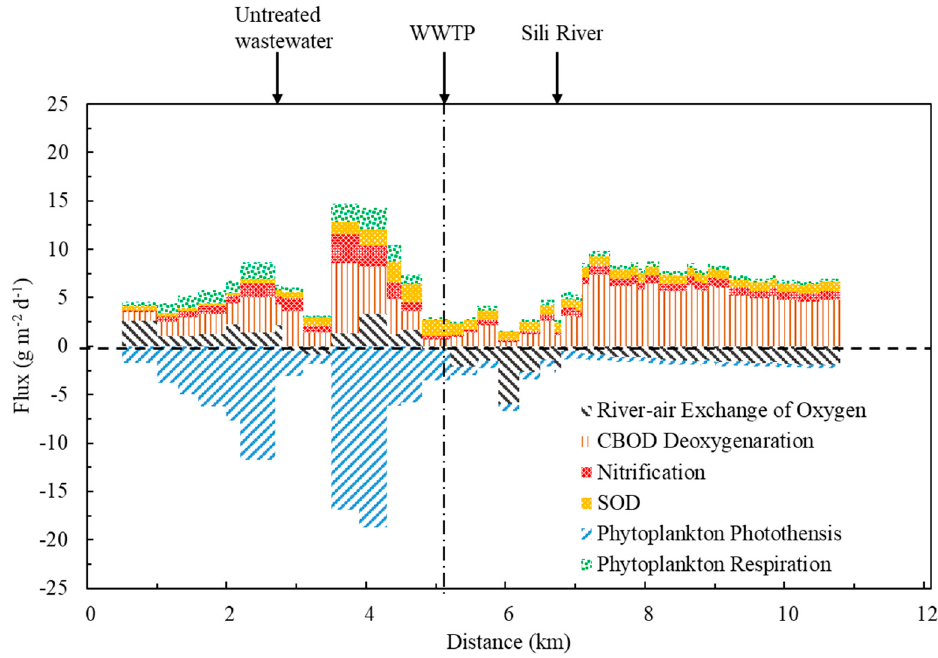
Figure 6. Areal rates of various DO sources and sinks under low flow conditions.